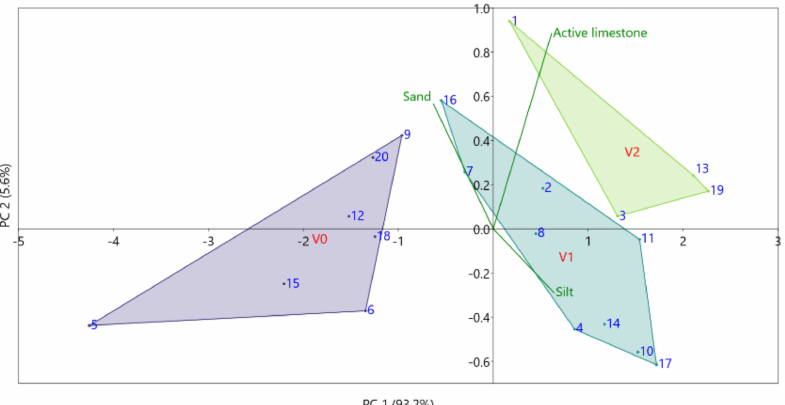
Figure 2. PCA plot of the flooding vulnerability areas and soil properties with stronger influence. Each polygon represents the corresponding flooding vulnerability: non-vulnerable (V0), mild (V1), extreme